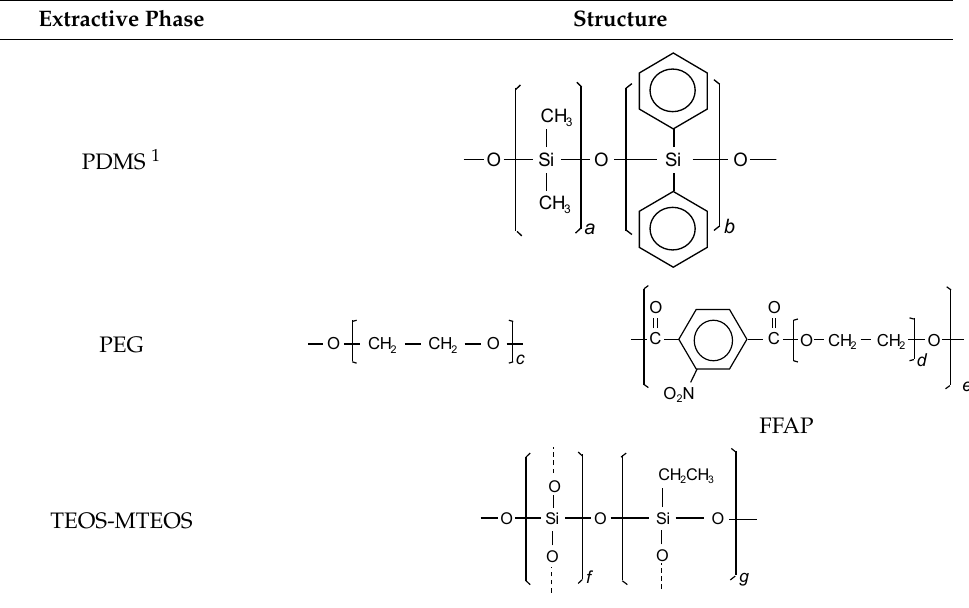
Table 2. Structure of the polymeric coatings tested.